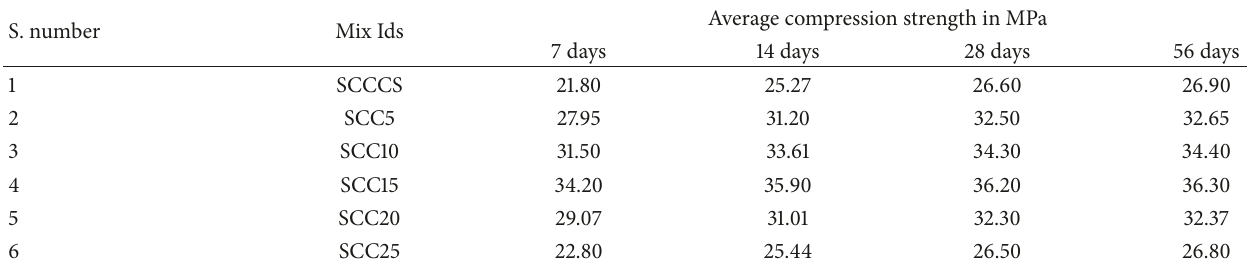
Table 3: Compressive strength of hardened concrete cubes.